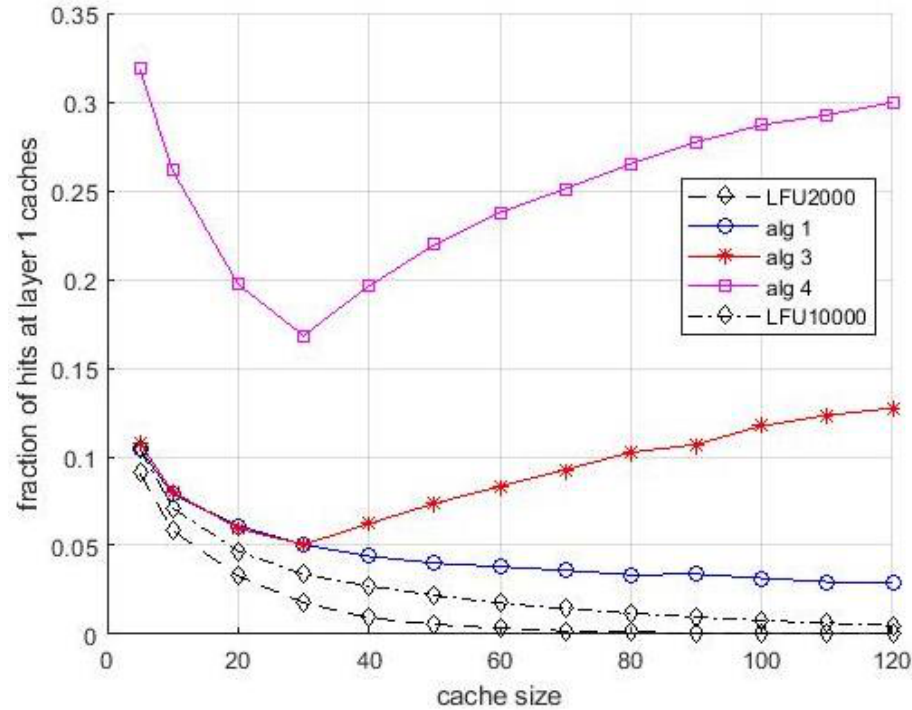
Figure 6. Fraction of hits at 1st layer caches, case 1, N =